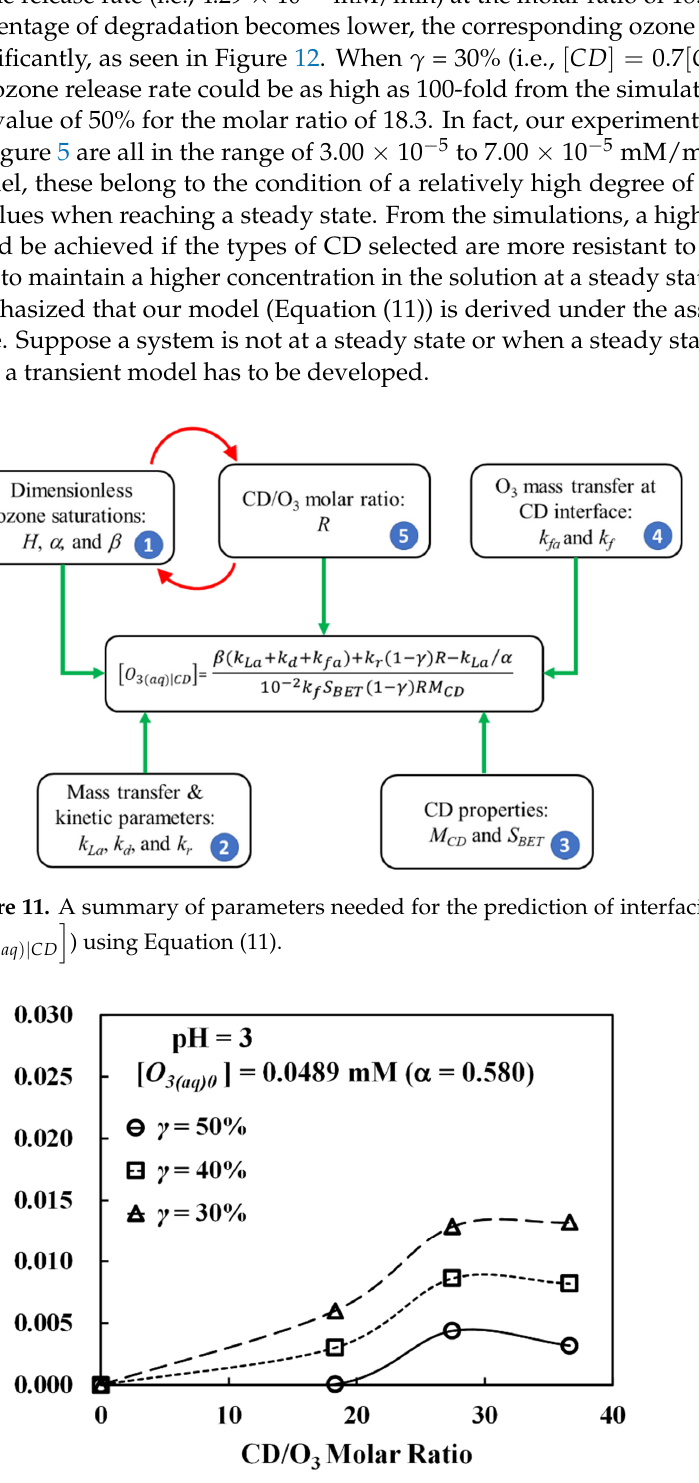
Figure 12. Simulated ozone release rate as a function of CD to ozone molar ratio under three different steady-state β -CD concentrations. The γ value in the legend represents the percentage of β -CD degraded at steady state. The k f and S BET values used are 3.98 × 10 − 4 cm/s and 1.017 m 2 /g, respectively. All other parameters in the model are the same as those listed in Table 2.